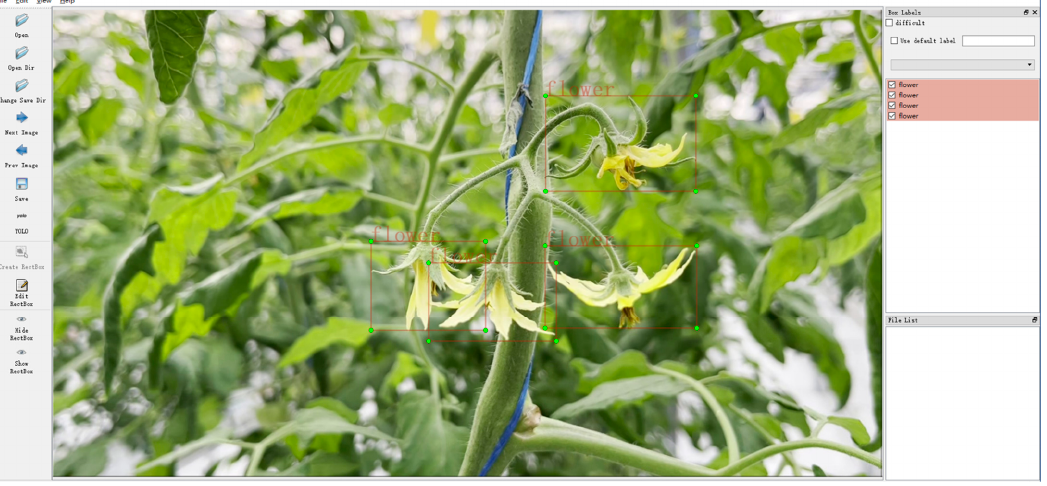
Figure 4. Data labeling.